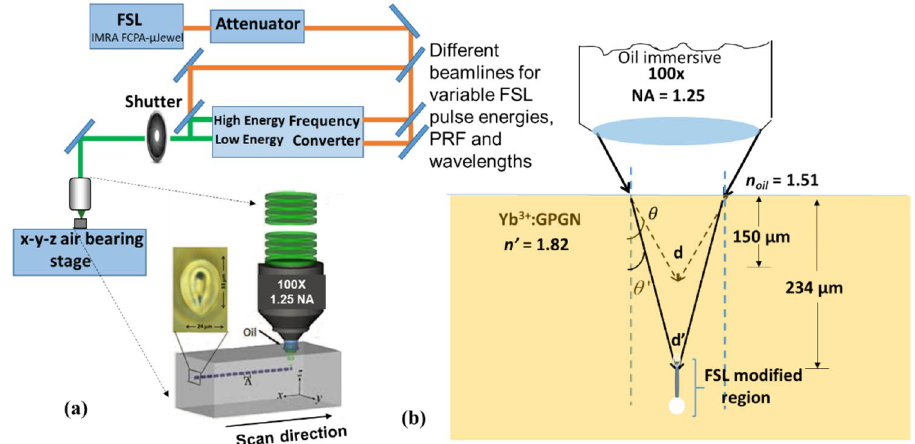
Figure 1. ( a ) FSL material processing setup for WG writing. The sample is moved transversely with respect to the FSL focus to inscribe tracks/lines of index modifications. The cross-section of the single line FSL modified region presented in the sample is the heat accumulated region (thermal writing regime). ( b ) Ray schematic showing the estimated change in writing depth [from d = 150 μm to d’ = 234 μm (FSL estimated focus)] through a low refractive index n = 1.51 index matching oil to a high refractive index sample (n’ = 1.82). θ and θ’ are the angle of refraction of the focusing beams (for actually set and estimated writing depths) with respect to incidence